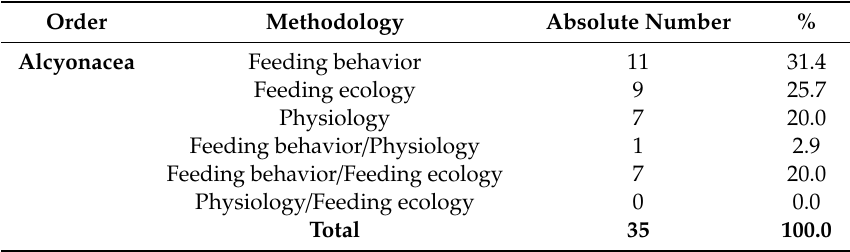
Table 5. Approach of the feeding studies in